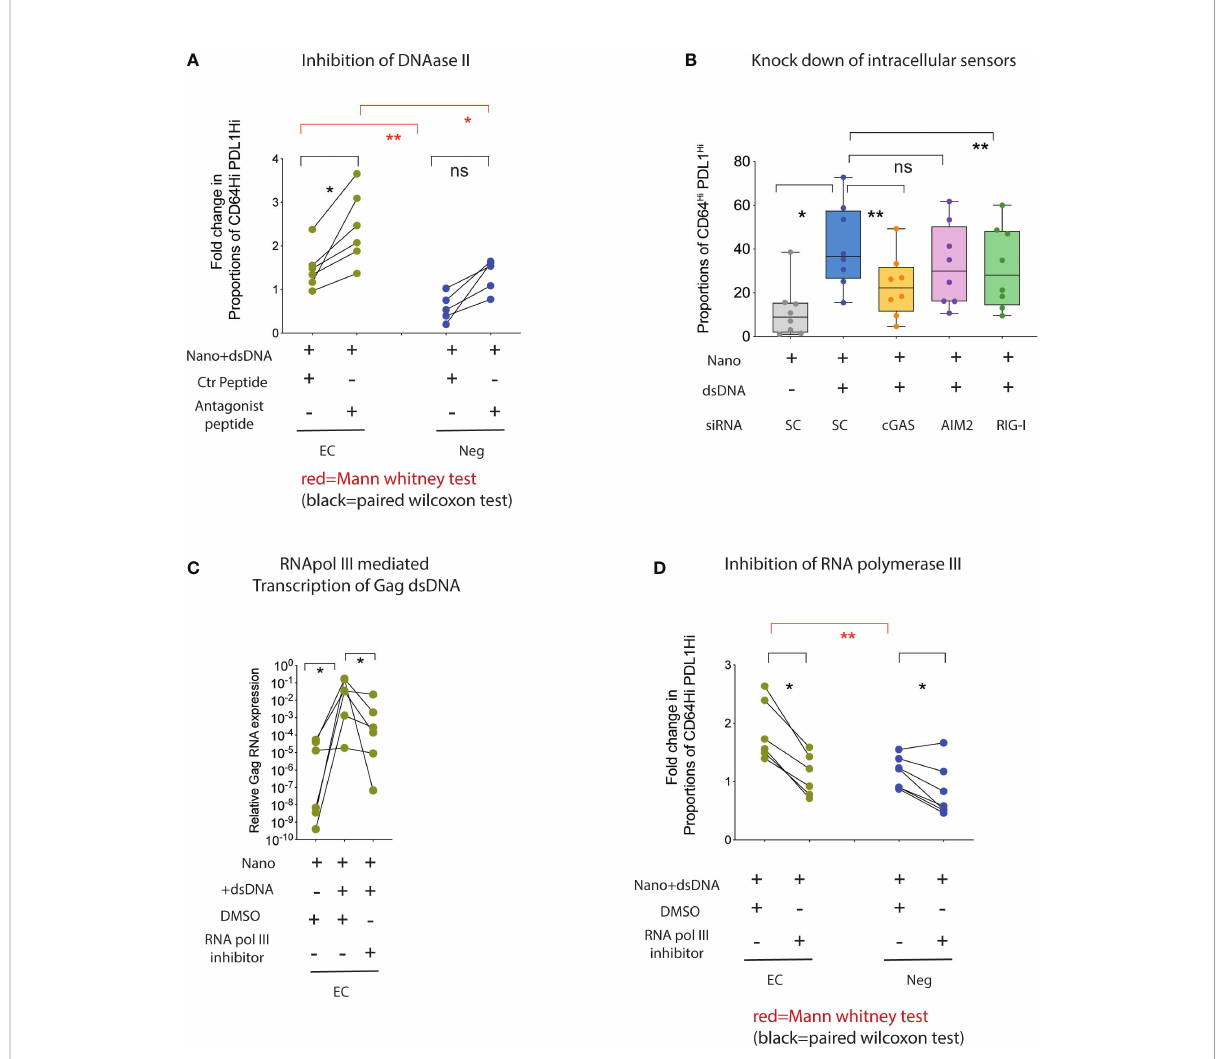
FIGURE 4 Collaboration of RNA polymerase III, cGAS and RIG-I enhance the detection of intracellular HIV-1 Gag dsDNA in mDC from high responder EC. (A, D) Proportions of CD64 Hi PD-L1 Hi mDC from HR-EC (green) and HIV-1 negative individuals (Neg, blue) after stimulation with nanoparticles loaded with HIV-1 Gag dsDNA or control nanoparticles. Experiments were performed in the presence of either a control peptide or an antagonistic peptide against DNAase II (A) or with DMSO or an inhibitor for RNA polymerase III (D) . Statistical signi fi cance was tested using two- tailed matched pairs Wilcoxon tests (black; * p<0.05) or Mann Whitney tests (red; *p<0.05; **p<0.01), respectively. (B) Fold change in proportions of CD64 Hi PD-L1 Hi mDC in response to stimulation with HIV-1 dsDNA after nucleofection with siRNAs speci fi c for genes encoding the indicated intracellular nucleic acid sensors. Data were normalized to mDC nucleofected with control scramble (SC) siRNAs in the presence of HIV-1 dsDNA stimulation. Baseline normalized levels of mDC nucleofected with scramble siRNA in the absence of HIV-1 dsDNA are also included. (C) RT-qPCR analysis of HIV-1 Gag mRNA in mDC from high responder EC cultured with control nanoparticles (Nano) or nanoparticles loaded with HIV-1 gag dsDNA. Experiments were performed in the presence of DMSO or an inhibitor for RNA polymerase III. ns, not signi fi